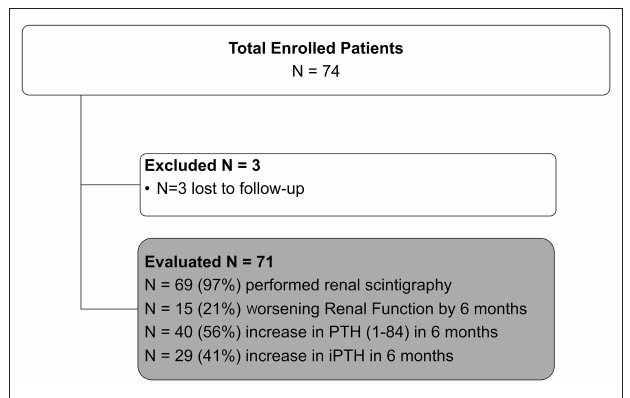
FIGURE 1 | PASCaL clinical trial enrollment flow chart with endpoint